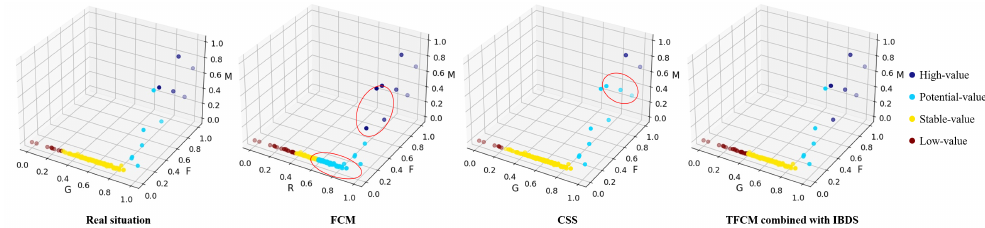
Figure 3. Comparison of different clustering